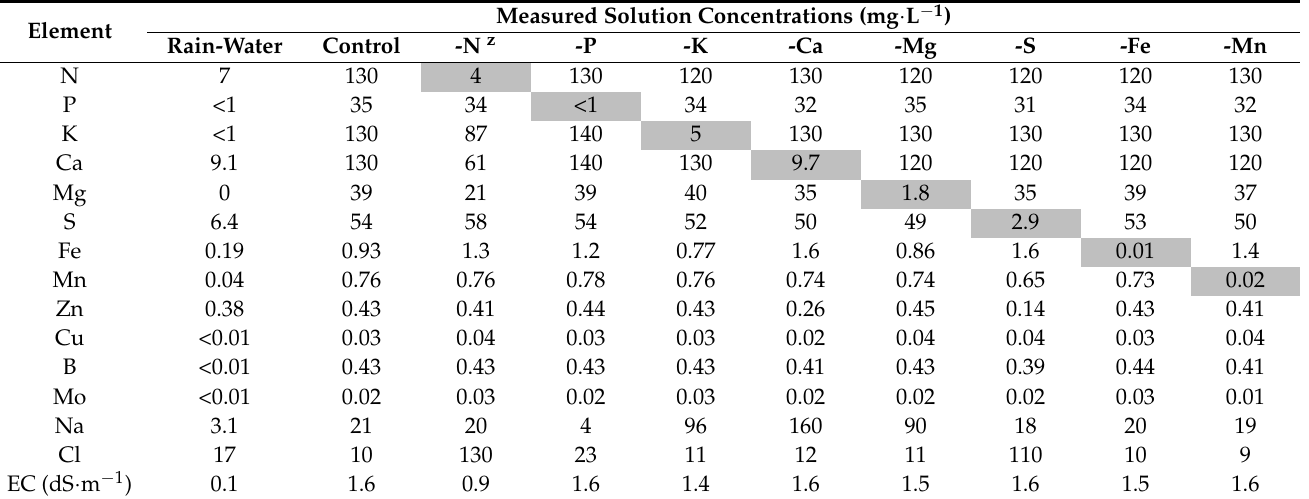
Table 3. Concentrations (mg · L − 1 ) of nutrient elements (plus Na) and electrical conductivity (EC, µ S · cm − 1 ) in the rainwater and each of the nutrient treatments according to third party laboratory analysis of freshly made batches of solutions. Shaded cells highlight the elemental concentrations of the deficient nutrient in the respective